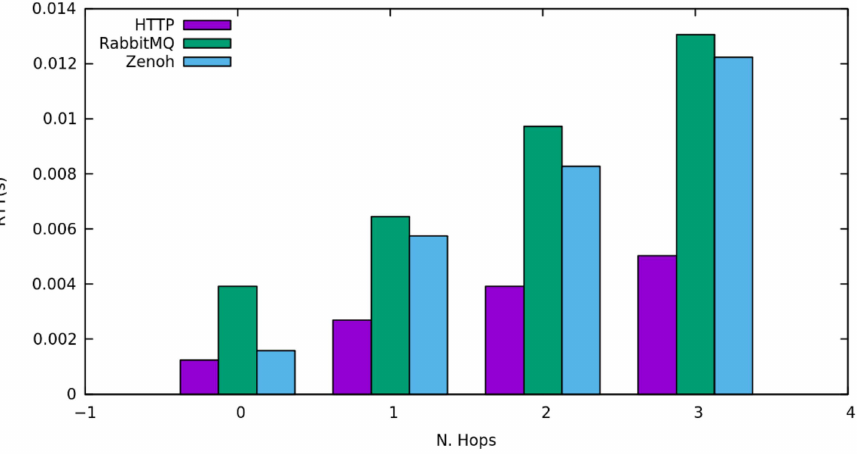
Figure 4. Round trip time of requests when traversing an increasing number of network hops.